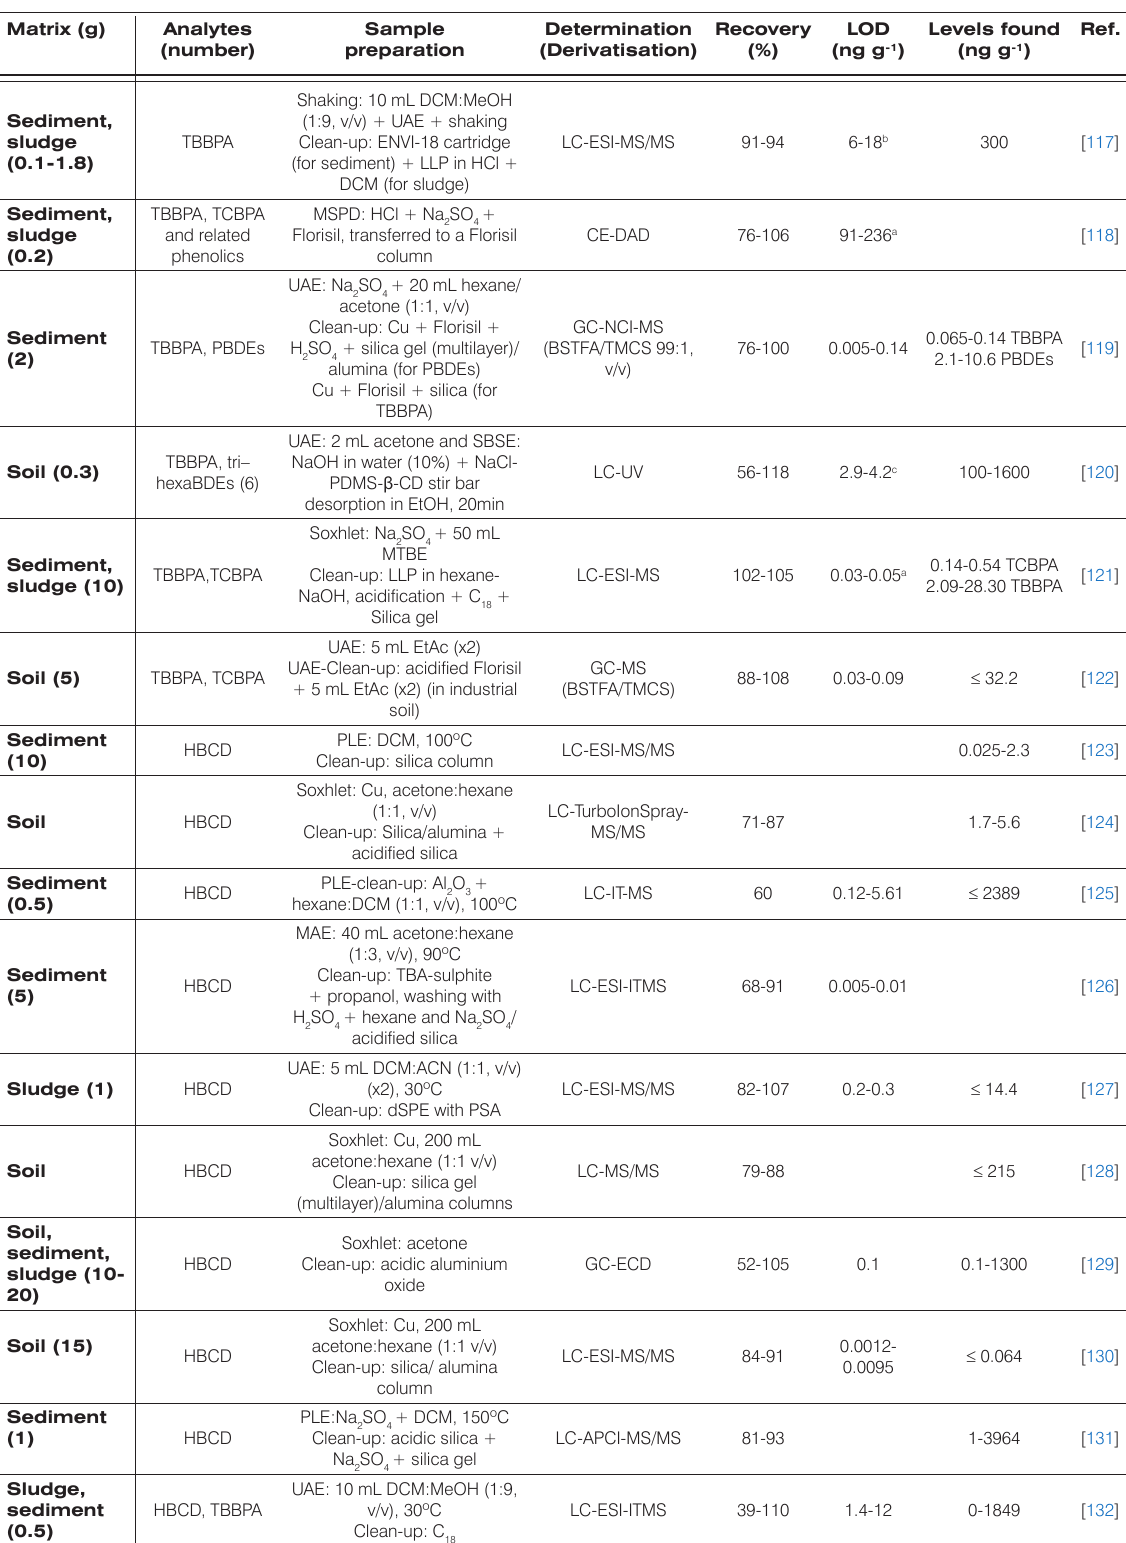
Table 4. Analysis of HBCD and TBBPA in environmental solid